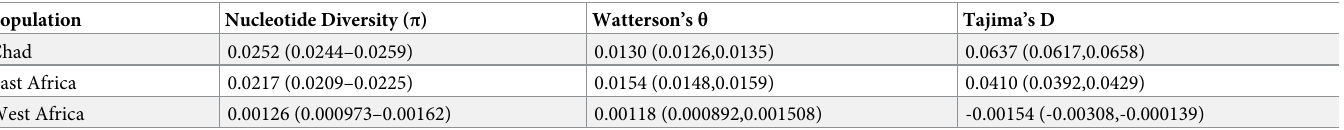
Table 2. Population genetic summary statistics for Dracunculus medinensis populations. Values are means and 95% bootstrap confidence intervals for the means of 1kb windows containing between 5 and 100 informative (variable) sites.